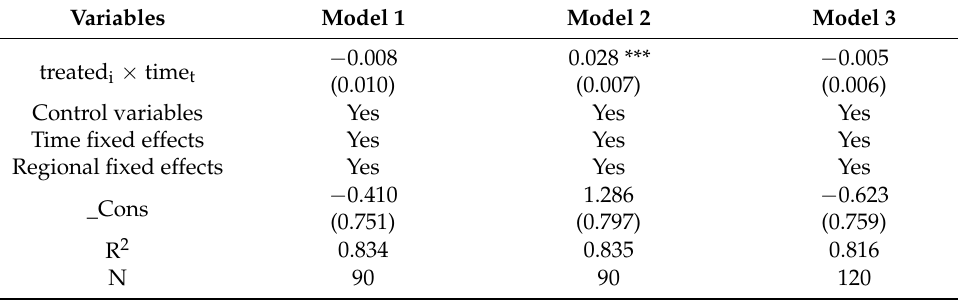
Table 5. Results of heterogeneity of natural geographic